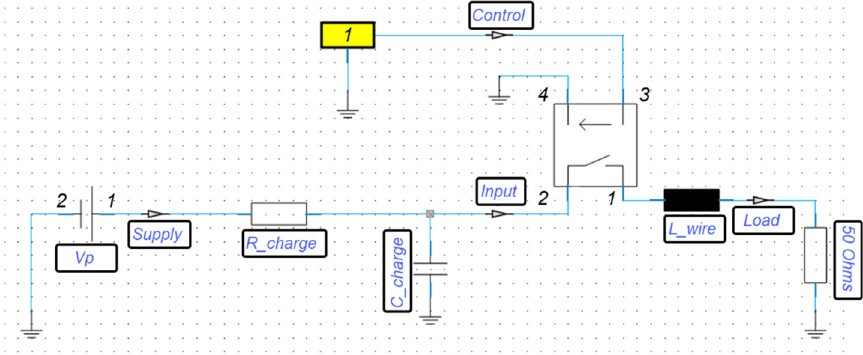
Figure 9. Schematics of a switch test stand: R on = 55 Ω , R off = 1 M Ω ; R charge = 0.5 Ω , C charge = 200 nF, L wire = 50 nH, R load = 50 Ω .